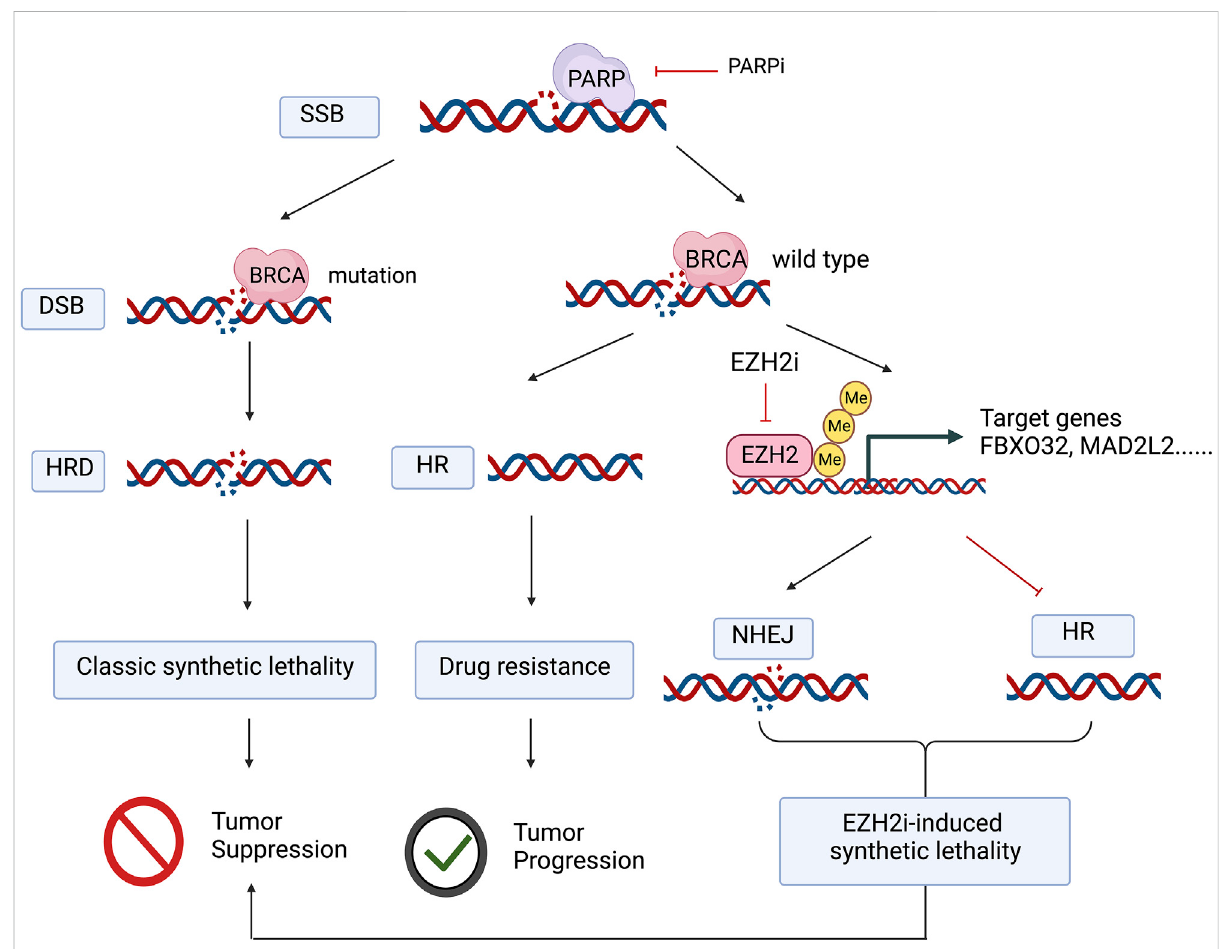
FIGURE 1 TheapplicationofPARPinhibitorsintumorswithBRCAmutationsblocks bothDNAsingle-strandand double-strand damagerepair, theclassic synthetic lethal mechanism, whereas in BRCA wild-type tumors, even though PARP inhibitors prevent the repair of DNA single-strand breaks and further DNA double-strand breaks occur, tumor cells can still repair DNA damage due to homologous recombination repair. EZH2 inhibitors promote nonhomologous recombination repair and inhibit homologous recombination repair by deregulating histone trimethylation- mediated transcriptional repression of target genes, thus mimicking “ drug-induced synthetic lethality ” in concert with PARP inhibitors. Figure 1 was created with BioRender.com with a publication